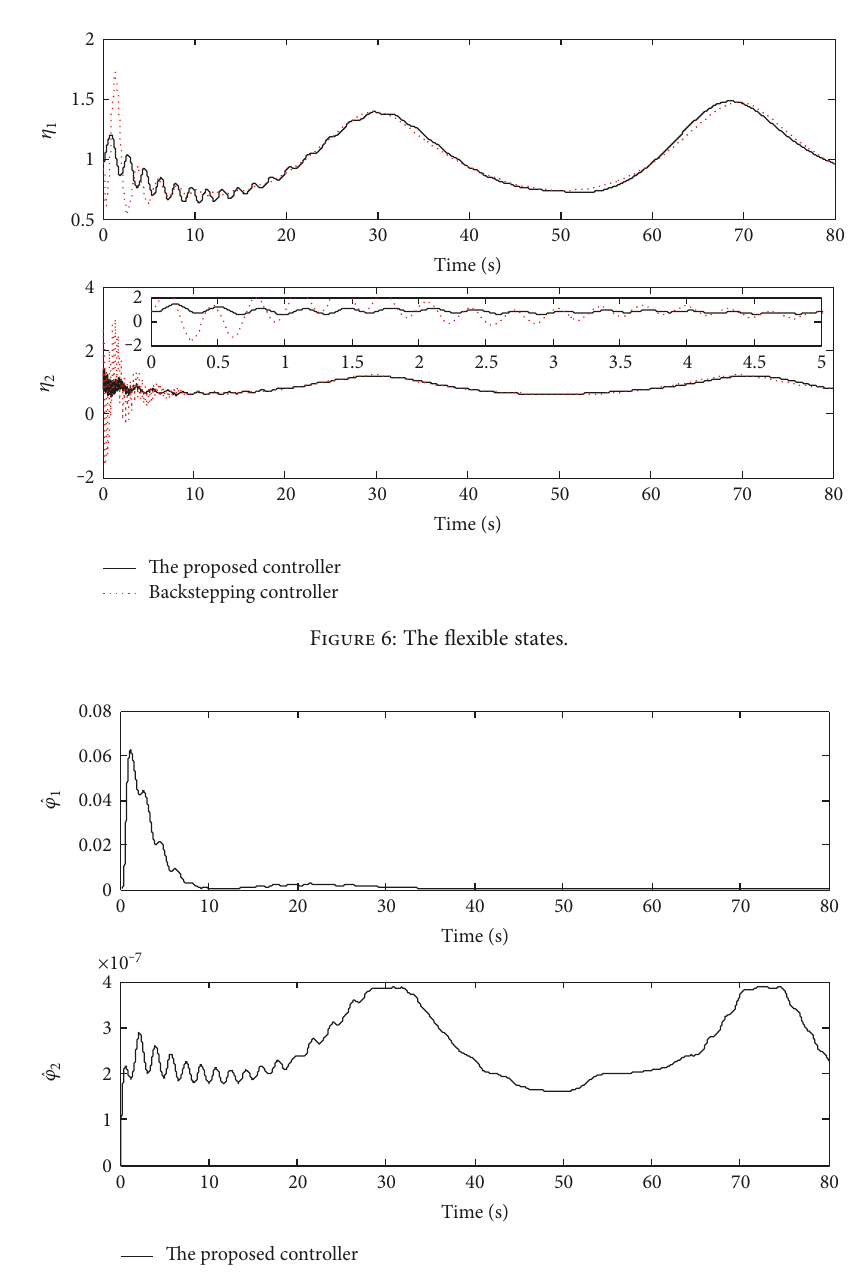
Figure 7: The estimations of φ